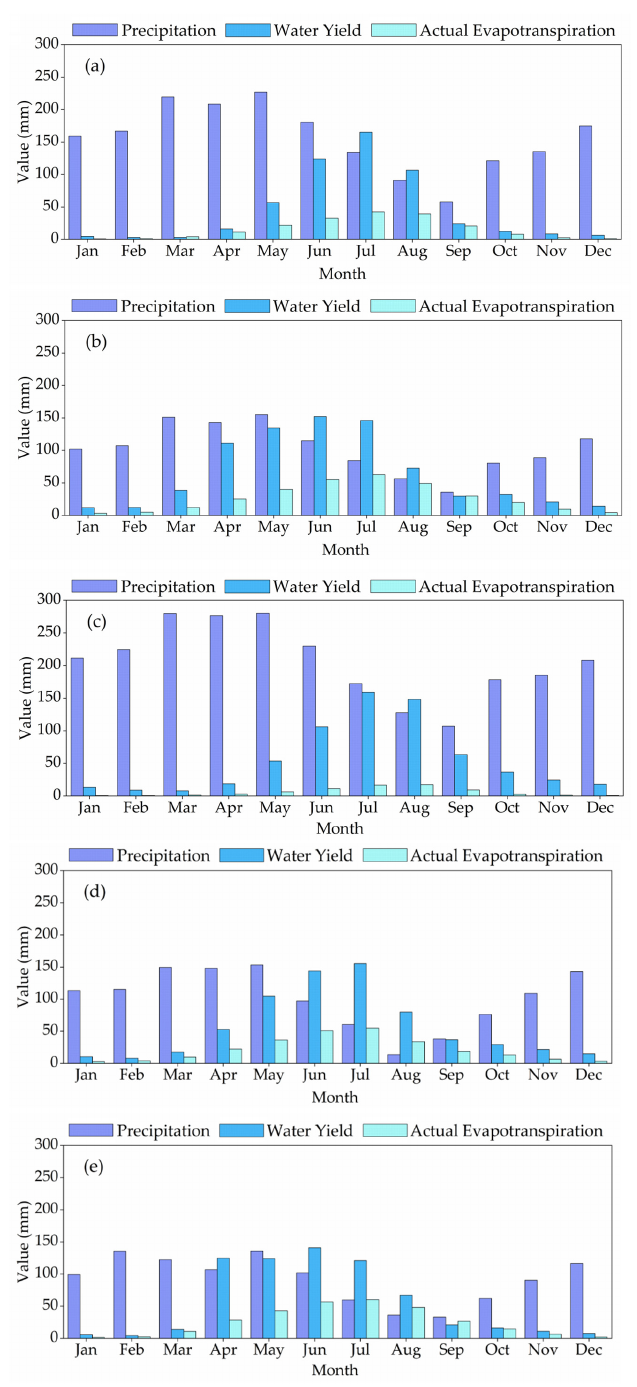
Figure 8. Mean monthly basin values of precipitation, water yield and actual evapotranspiration in the Upper Vakhsh River Basin in Central Asia, using ( a ) APHRODITE_V1101+CFSR, ( b ) APHRODITE_V1101+CRU TS3.1, ( c ) CFSR, ( d ) CRU TS3.1, and ( e ) observational datasets.